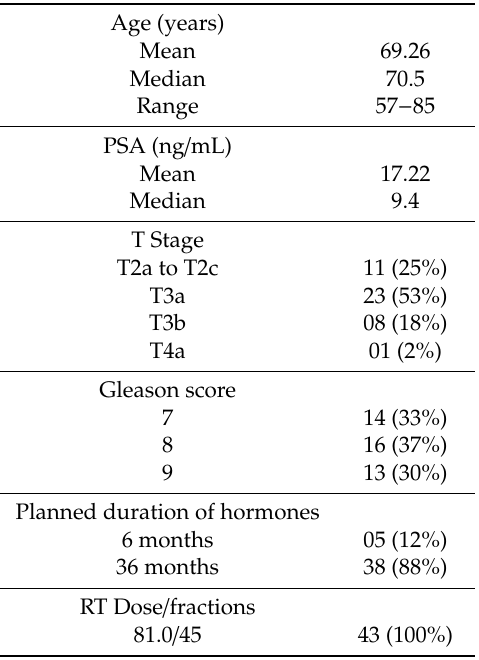
Table 5. Clinical features of prostate cancer patients used in this